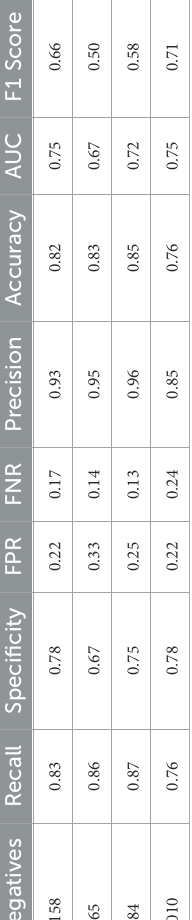
TABLE 4 Logistic regression model cross validation